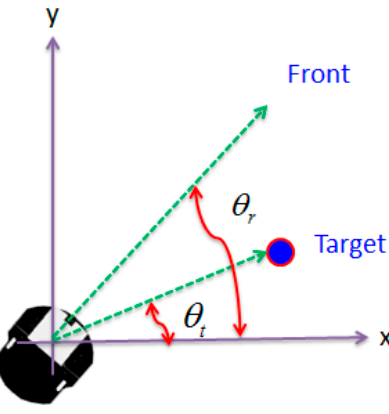
new solutions discard